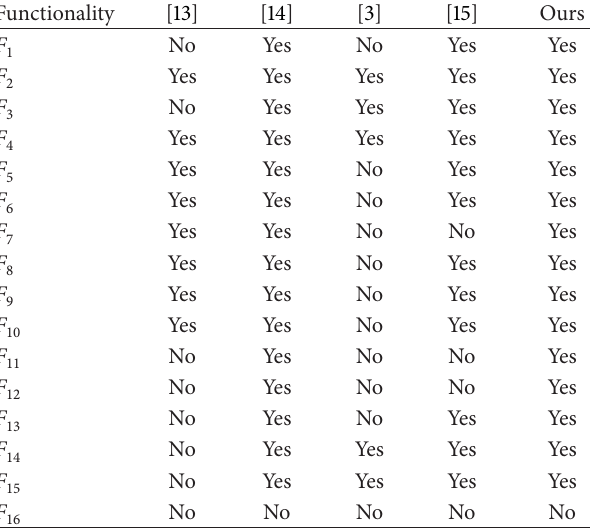
Table 6: Functionality comparison between our scheme and other schemes.